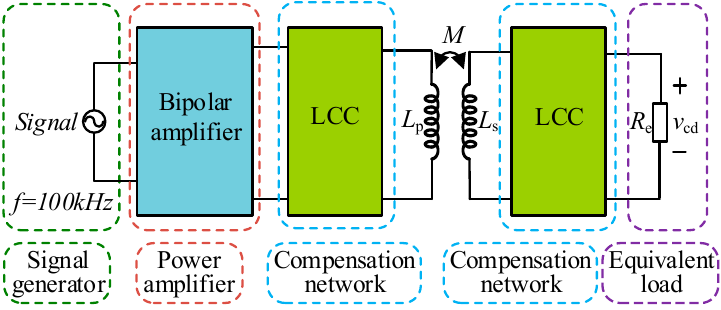
Figure 8. Schematic diagram of the experimental prototype.